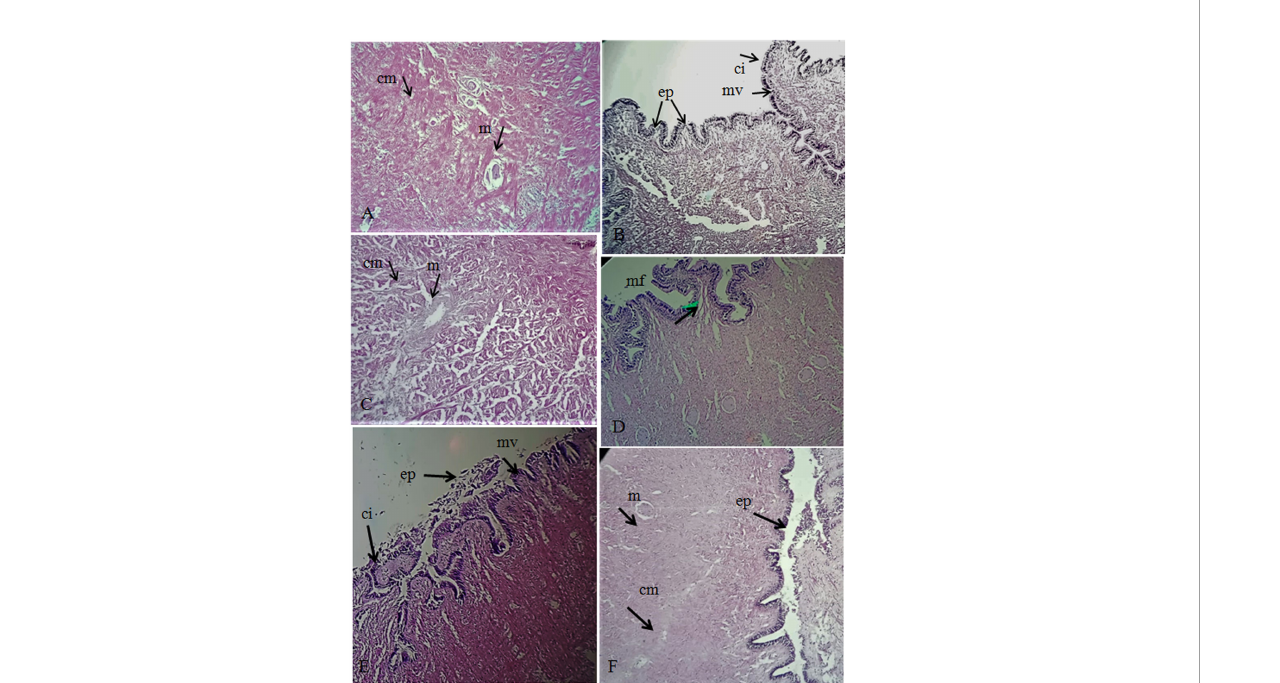
FIGURE 6 (A) Foot tissue (TS) of control snail showing normal columnar muscle cells (cm) and mucocytes (m). (B) Foot TS of control snail showing normal epithelium. (C) Foot TS of exposed snails showing emptied and shrinkage mucocytes (m) and deranged columnar muscle fi bers (cm) with increased spaces in between them (arrow). (D) The epithelium (ep) was partially damaged, and the microvilli (mv) started to denature with deranged cilia. (E) The ep was eroded and the cilia (ci) scattered and deranged with deforming microvilli (mv). (F) Normal foot TS of snail from the intake structure of KANUPP, showing normal epithelium (ep), microvilli (mv), and columnar muscle fi bers